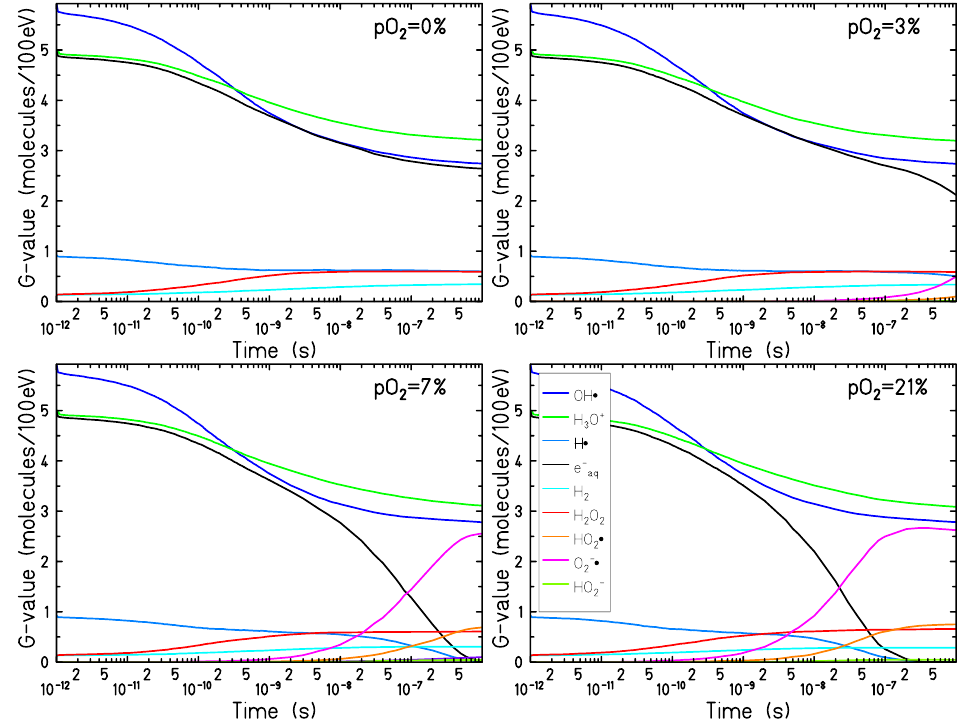
Figure 1. Time dependent yield of the chemical species generated by a 90 MeV proton track (linear energy transfer (LET) = 0.56 keV/ µ m) in a pure water target ( top left ) and in an oxygenated water target in equilibrium with an atmospheric partial oxygen pressure at the water surface of 3% ( top right ), 7% ( bottom left ), and 21% ( bottom right ).